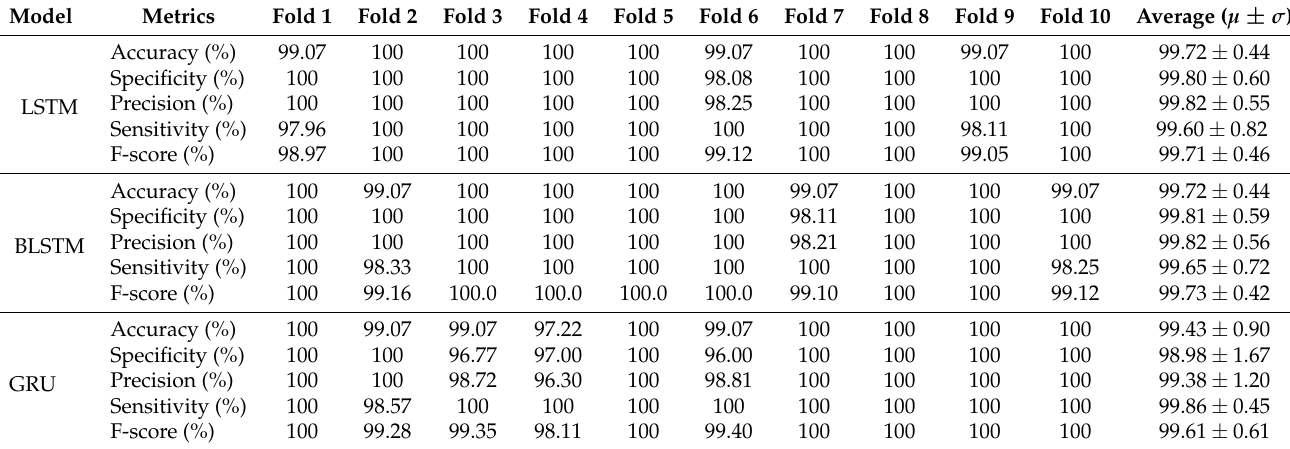
Table 10. The classification performance obtained using RNN-based classifiers with the 10-fold CV approach for the automated classification of the BFMAC vs. DMAC